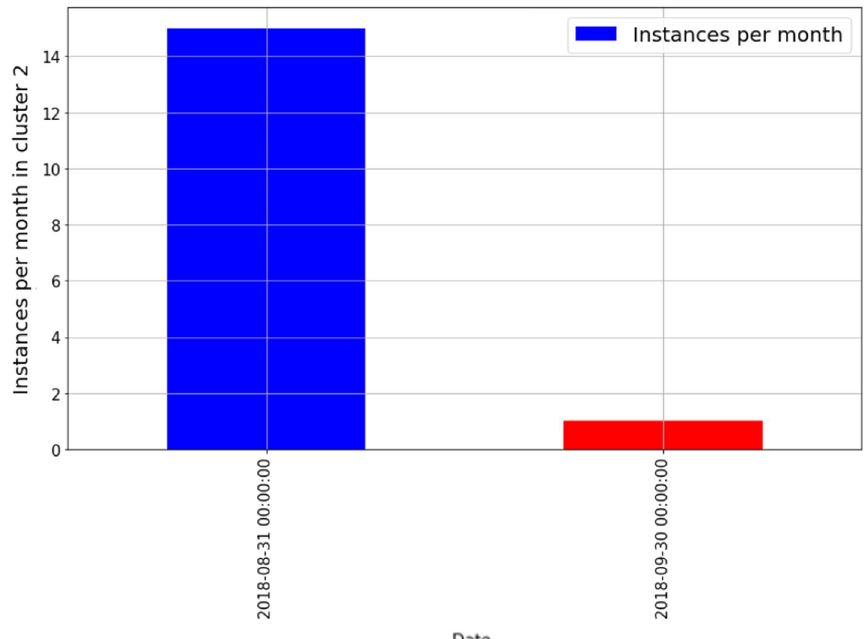
Fig. 26 Monthly distribution of the daily profiles in cluster 2 (Note: the x-axis dates represent the entire, specific month)